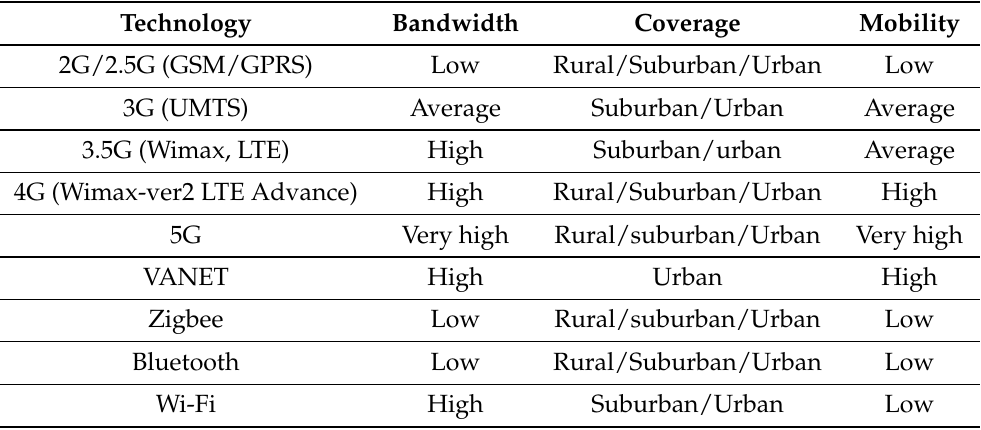
Table 5. Summary of communication technologies deployable for mHealth